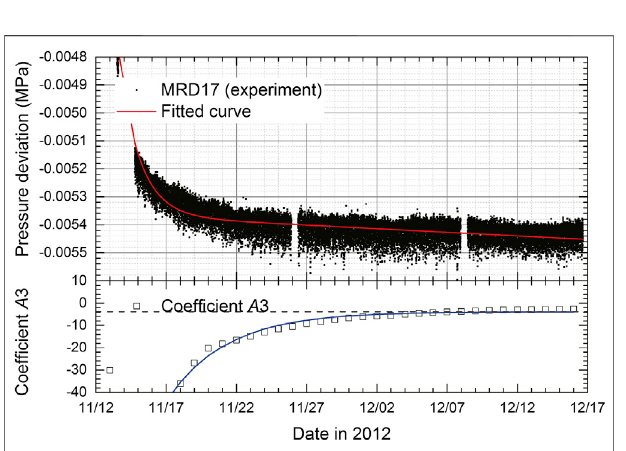
FIGURE 12 | Deviation from the pressure standard (reference pressure) of the MRD17 pressure sensor and variation of coef fi cient A 3 during the experiment. The unit is Pa/day.